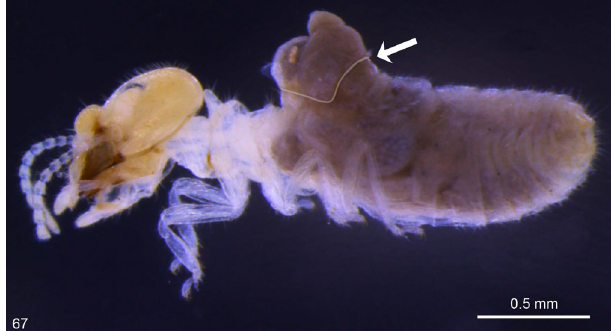
Fig 67. Crepititermes verruculosus worker (arrow: abscission line on the first abdominal tergite, highlighted).